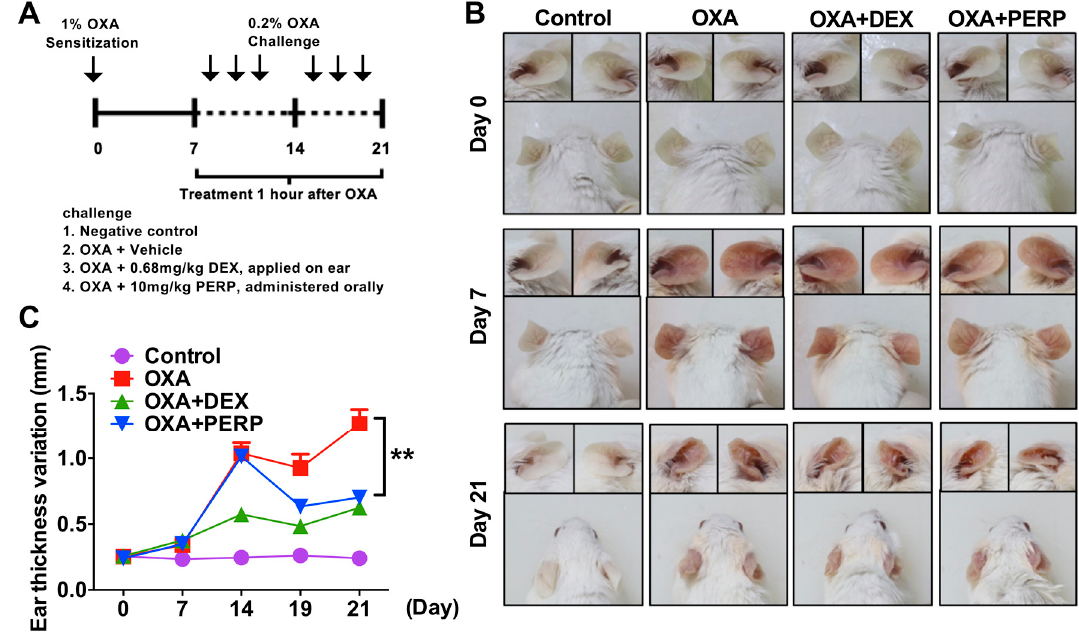
Figure 3. Perphenazine alleviates morphological phenotype of OXA-induced dermatitis model in mice. ( A ) Schematic diagram of an OXA (Oxazolone)-induced animal model. Four groups: untreated controls, OXA only and mice treated with DEX (Dexamethasone) or Perphenazine (PERP) one hour after every OXA challenge ( n = 7). ( B ) Representative photographs of mouse ears from each group on day zero, seven, and 21. ( C ) Ear thickness was measured every week as indicated. Data are presented as mean ± SEM and analyzed by the student t-test. ** p < 0.01 vs. oxazolone treated.